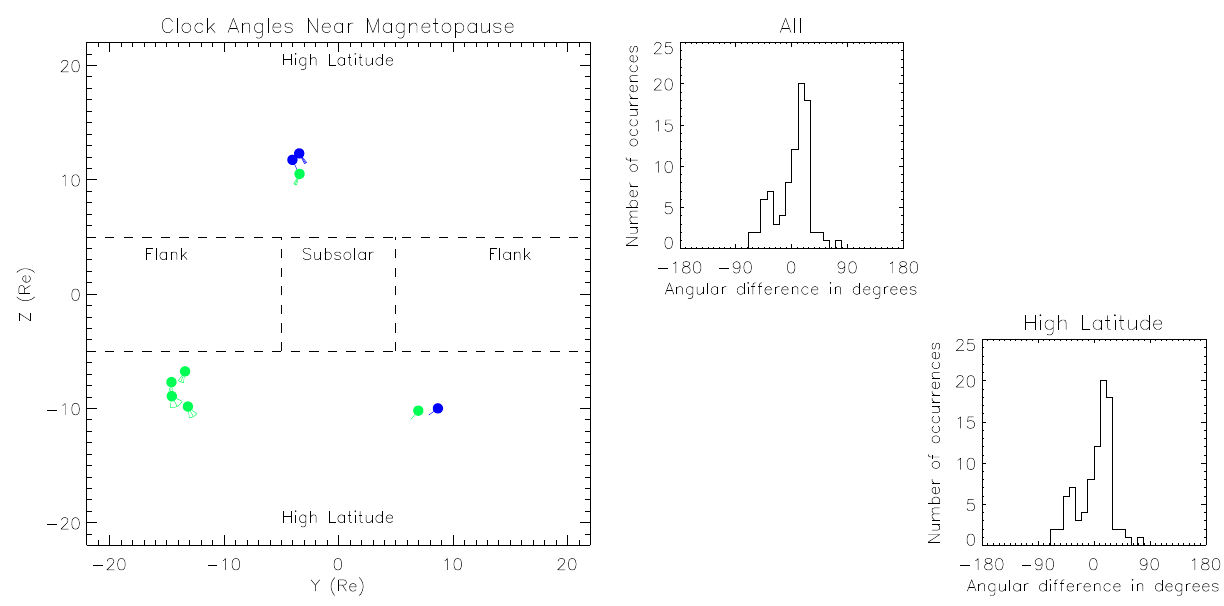
Fig. 12. Clock angles measured near magnetopause, and angular differences from perfect draping, for low solar wind dynamic pressure and Southward IMF. Format as Fig.